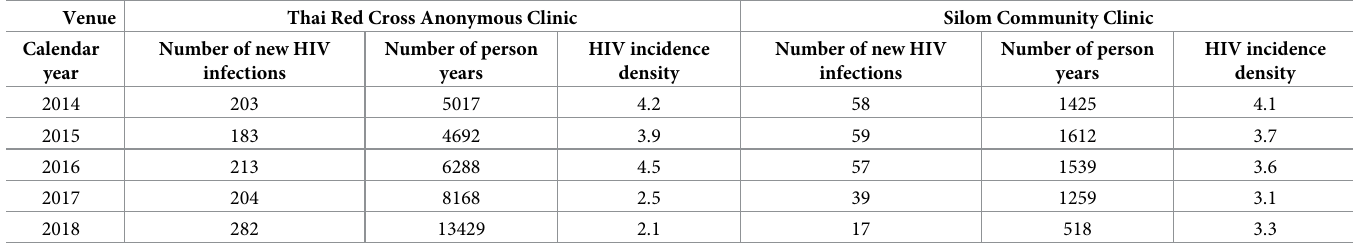
Table 3. HIV incidence density among men who have sex with men attending HIV testing and counseling services at the Thai Red Cross Anonymous Clinic and Silom Community Clinic, Bangkok 2014–2018. Venue Thai Red Cross Anonymous